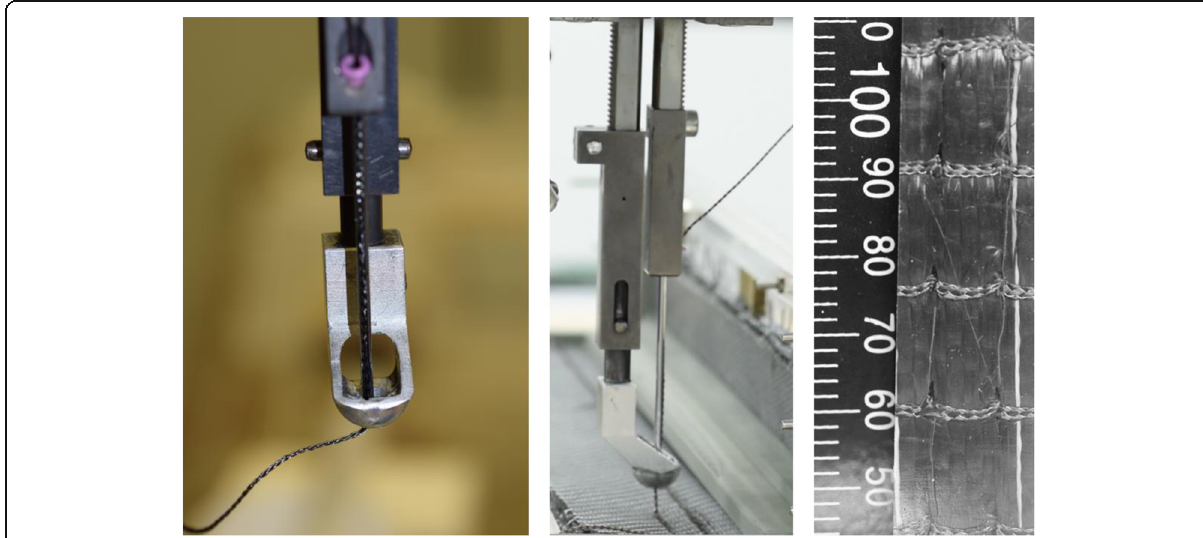
Fig. 1 Tufting needle and thread, tufting into preform tufted